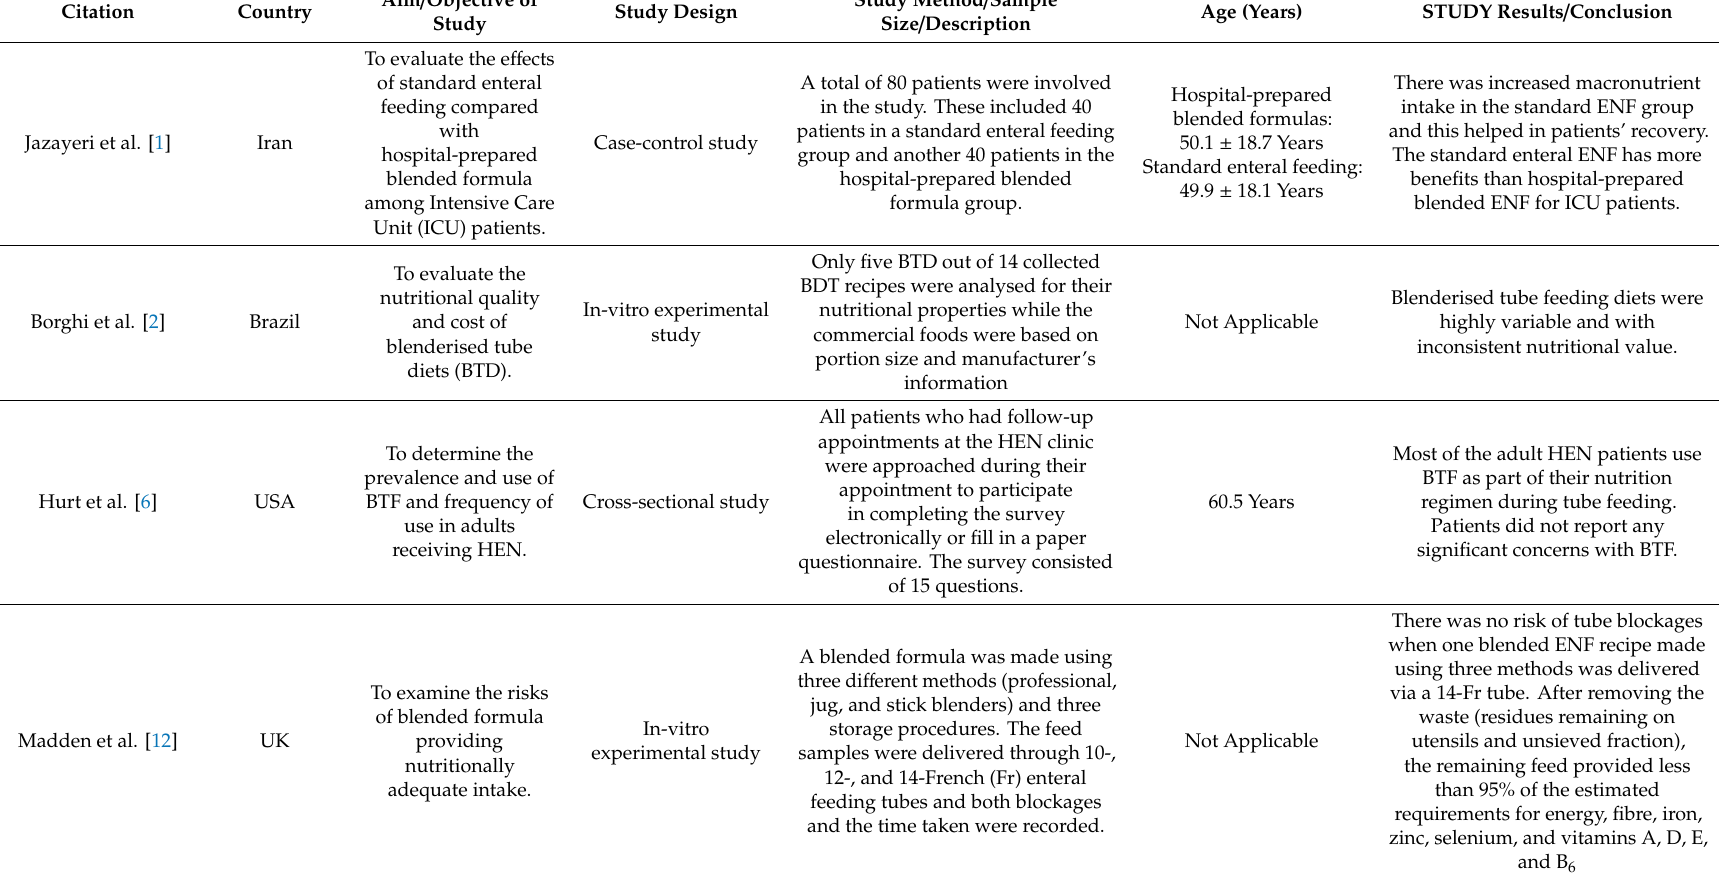
Table 1. Shows results of the data extracted from the studies